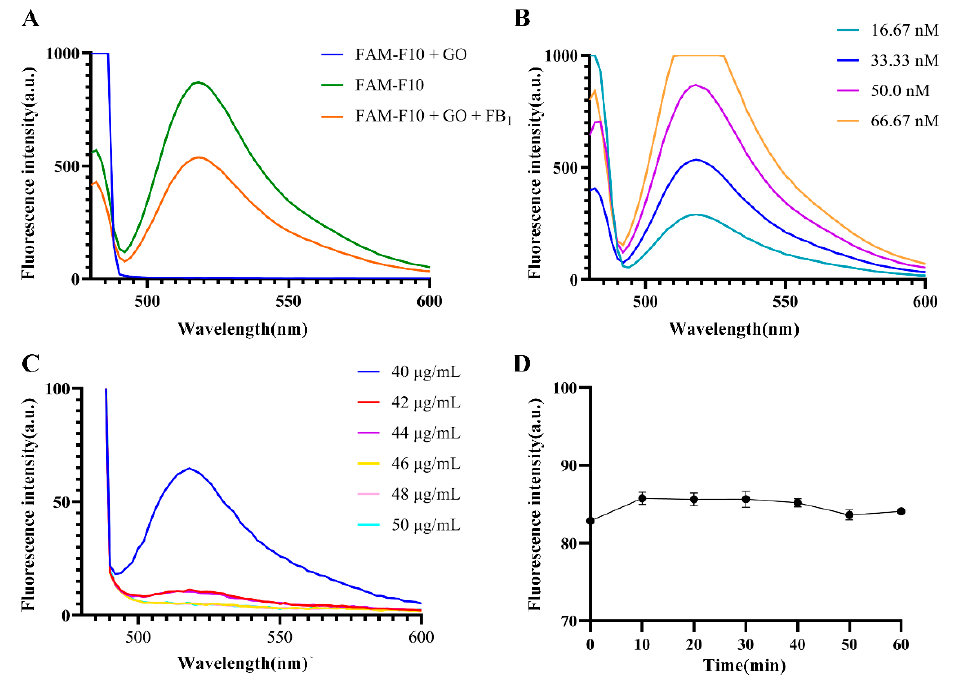
Figure 1. Optimization of experimental conditions. ( A ) Relationship between fluorescence intensity and wavelength in the presence of FB 1 . ( B ) Optimization of the FAM-F10 concentration. ( C ) Optimization of the GO concentration. ( D ) Optimization of the incubation time.